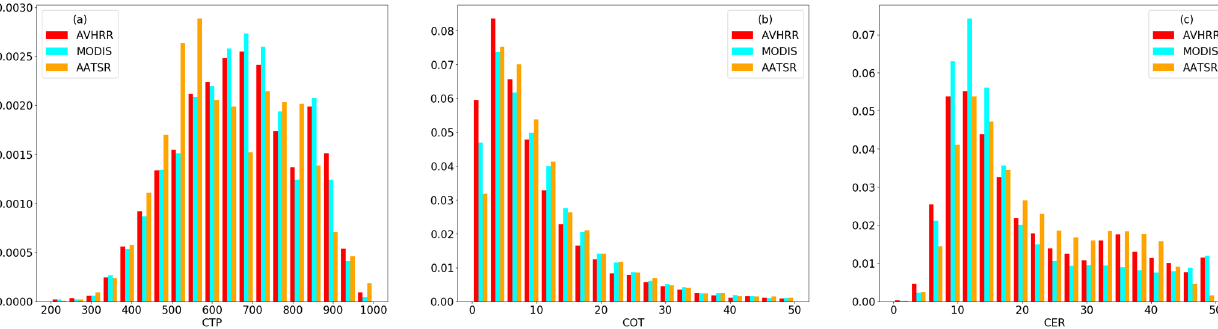
Figure 8. Density histograms of NOAA18 (N18), MODIS AQUA (MYD), and AATSR (ENV) retrieval data for study area NA2 and (a) CTP, (b) COT, and (c)